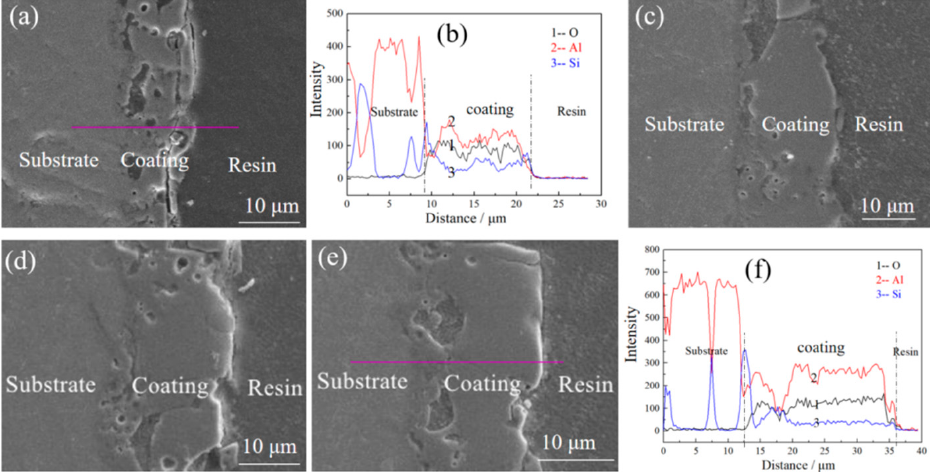
Figure 7. Cross-sectional images and EDS composition depth profiles of the coatings on the Al-12 Si by ( a , b ) 0, ( c ) 15, ( d ) 30 and ( e , f ) 60 s etching, respectively, and then 30 min MAO treatment.